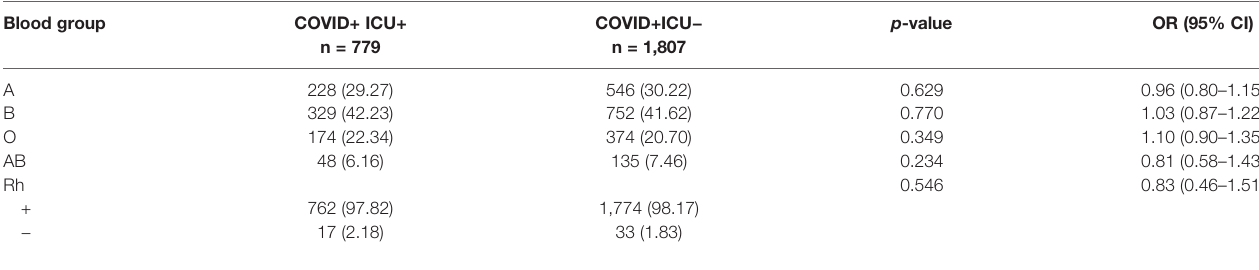
TABLE 2 | Distribution of ABO and Rh blood groups between COVID+ ICU+ and COVID+ ICU − . Blood group COVID+